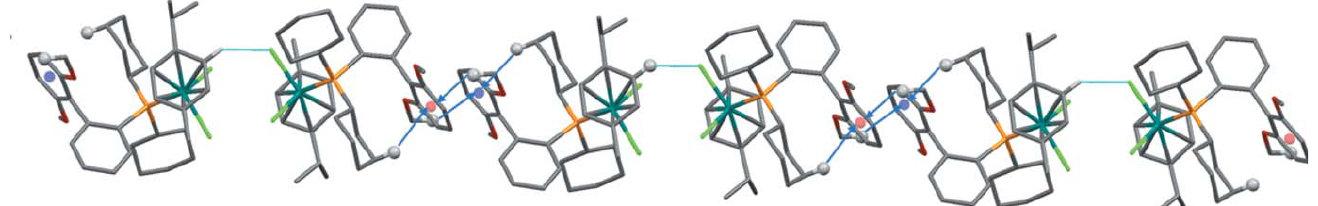
Figure 3 Aview of the C—H (cid:2)(cid:2)(cid:2) Cl hydrogen bonds (dashed lines) and the C—H (cid:2)(cid:2)(cid:2) (cid:3) interactions (blue arrows) leading to the formation of chains along [100]; see Table 1 for details. Only the H atoms involved in these interactions are shown, and the centroid in molecule A is red, while the centroid in molecule B is blue.